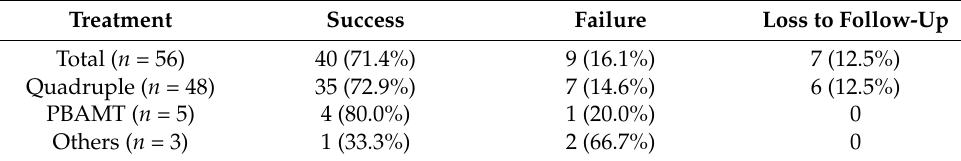
Table 5. Second-line